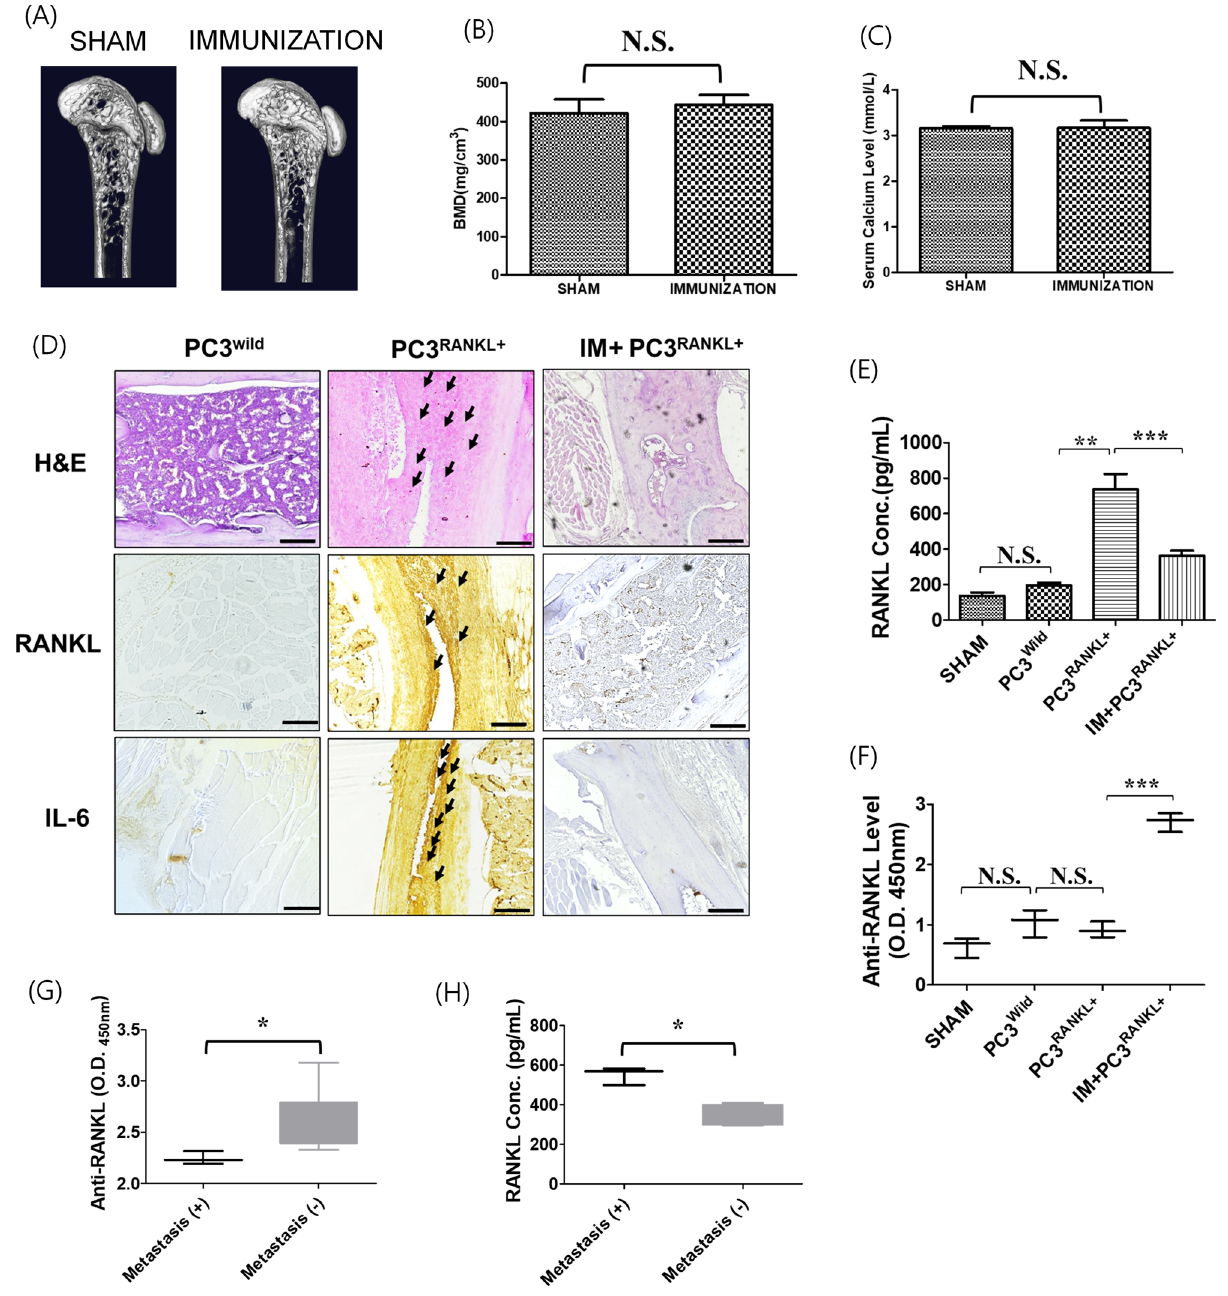
Figure 4. Effects of immunisation with mutant RANKL on PC3-the innoculated metastatic model. ( A ) Three- dimensional micro-CT images revealed the trabecular bone architecture of the volume of interest in SHAM and mRANKL-immunized (IMMUNIZATION) mouse femurs (n = 10 images taken in total, one image for each mouse). ( B ) Bone mineral density (BMD) and ( C ) Serum calcium Level are shown. No significant differences were observed between two groups. (N.S.) ( D ) representative H&E stained and immunostained images of RANKL and IL-6 in the PC3 Wild , PC3 RANKL+ and PC3 RANKL+ + IM groups. The metastatic tumor cells or immuno- positive cells were indicated by black arrows. Magnification: × 200. Scale bar = 100 μm. ( E ) Concentration of RANKL in mouse serum. The mean ± SD values were obtained by densitometry, as shown in the analysis. Significant differences were observed at *p < 0.05 and **p < 0.01 vs. control. ( F ) Serum samples from mice were obtained after immunisation. Anti-RANKL values in PC3 Wild , PC3 RANKL+ and PC3 RANKL+ + IM groups. The mean ± SD values were obtained by densitometry, as shown in the analysis. Significant differences were observed at *p < 0.05 and **p < 0.01 vs. the control. ( G ) Anti-RANKL values and (H) RANKL concentration in the serum of RANKL - immunized mice with metastasis (+) or metastasis (−). Bar graphs show the mean ± standard deviation (SD). Significant differences were observed at *p < 0.05, metastasis (+) vs. no metastasis